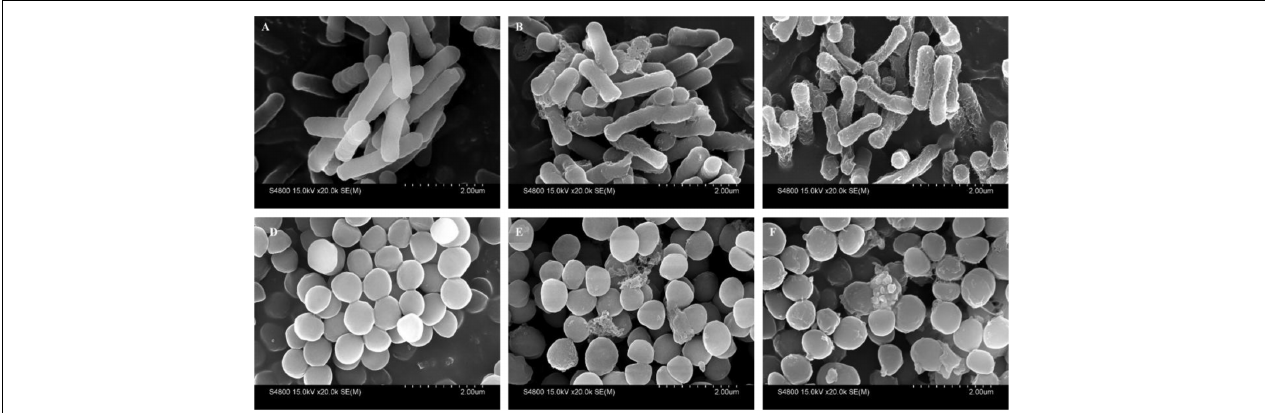
FIGURE 10 | Scanning electron micrographs of E. coli 25922 and S. aureus 29213 treated with PP and PQ. SEM micrographs of E. coli : (A) Control, no peptides; (B) PQ-treated, 16 µ M; (C) PP-treated, 8 µ M. SEM micrographs of S. aureus : (D) Control, no peptides; (E) PQ-treated, 8 µ M; (F) PP-treated, 16 µ M. Bacteria in mid-logarithmic growth were treated with peptides at 1 × MIC for 1 h.